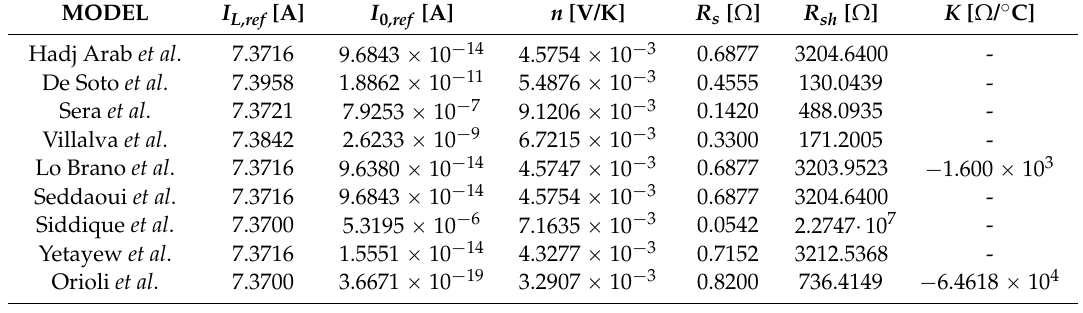
Table 4. Model parameters of Sanyo HIT-240 HDE4 at the SRC.